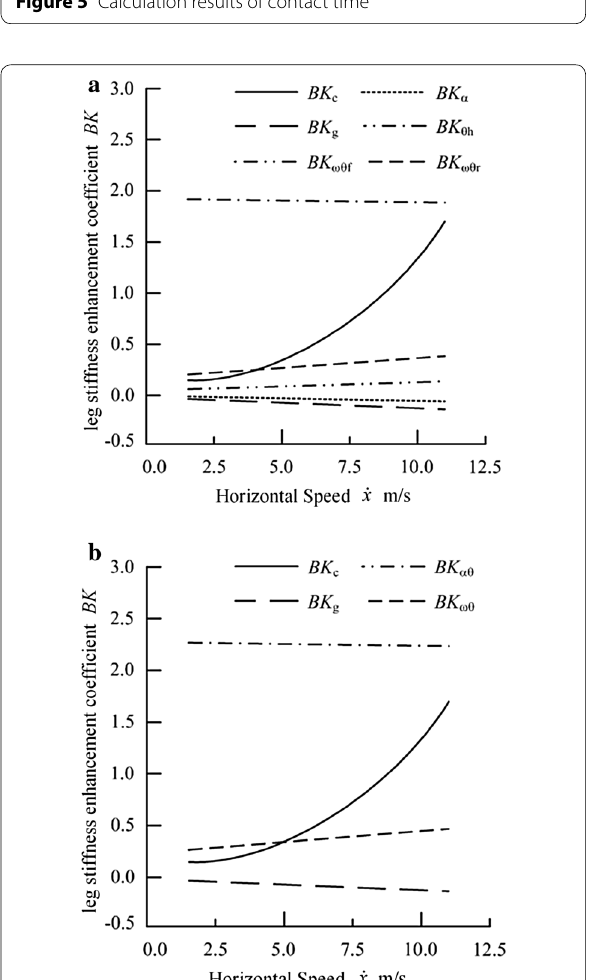
Figure 6 Calculation results of leg stiffness enhancement coefficients: a spine-joint model and b spring-beam model